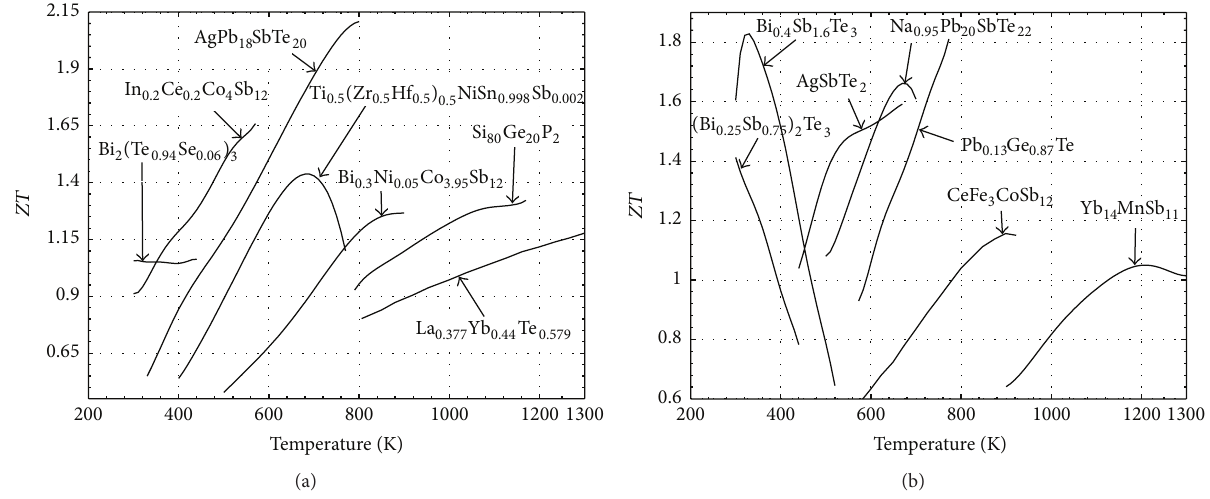
Figure 2: Temperature dependence of dimensionless figure of merit for (a) 𝑛 -type and (b) 𝑝 -type